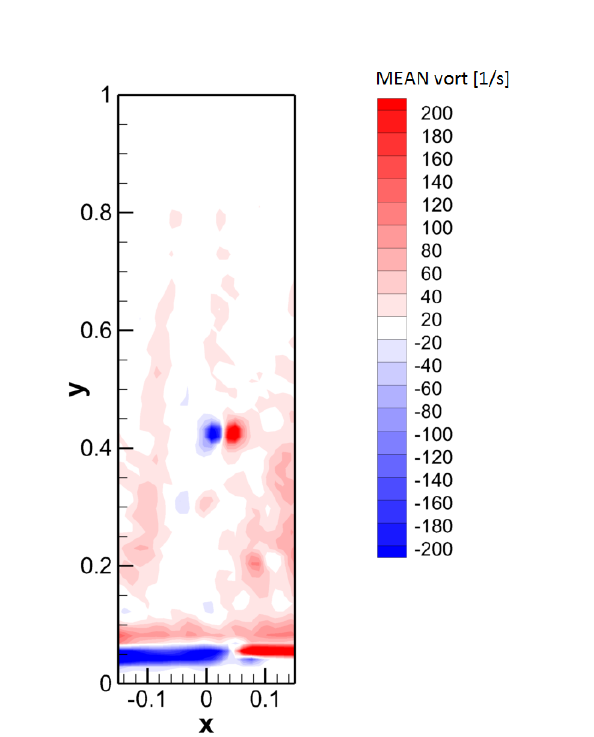
Fig. 7. Mean vorticity distribution.